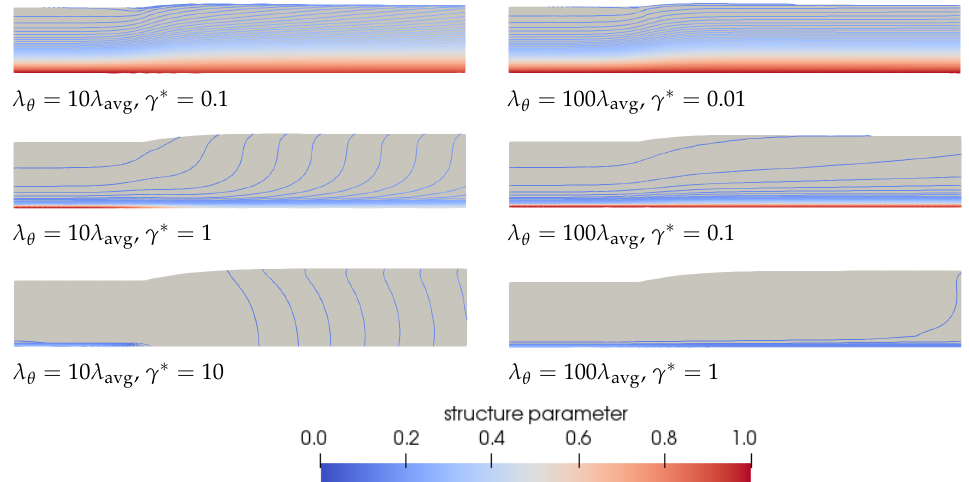
Figure 14. Contour plots of the structure parameter ξ predicted by the rate-controlled approach for λ θ = 10 λ avg ( left ) and λ θ = 100 λ avg ( right ) for different damage parameter and recovery time scale combinations that give the same ξ eq